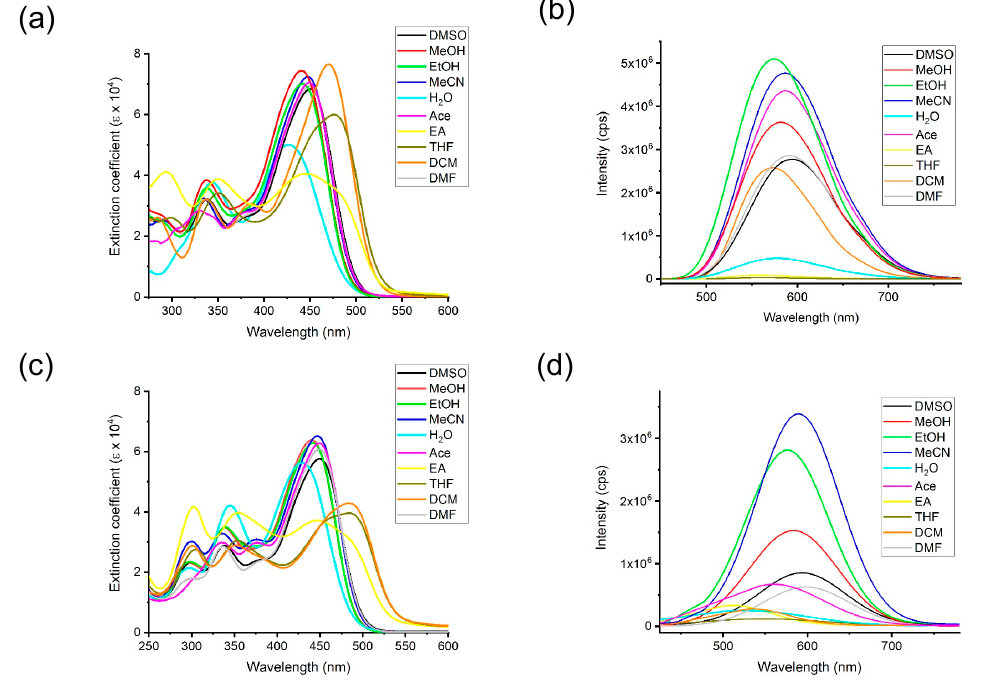
Figure 2. Normalized absorbance and fluorescence emission spectra of MeAcd12C ( a , b ) and MeAcd12P ( c , d ) in different solvents. The corresponding excitation wavelengths were determined from the absorption maxima present in each absorbance spectrum.